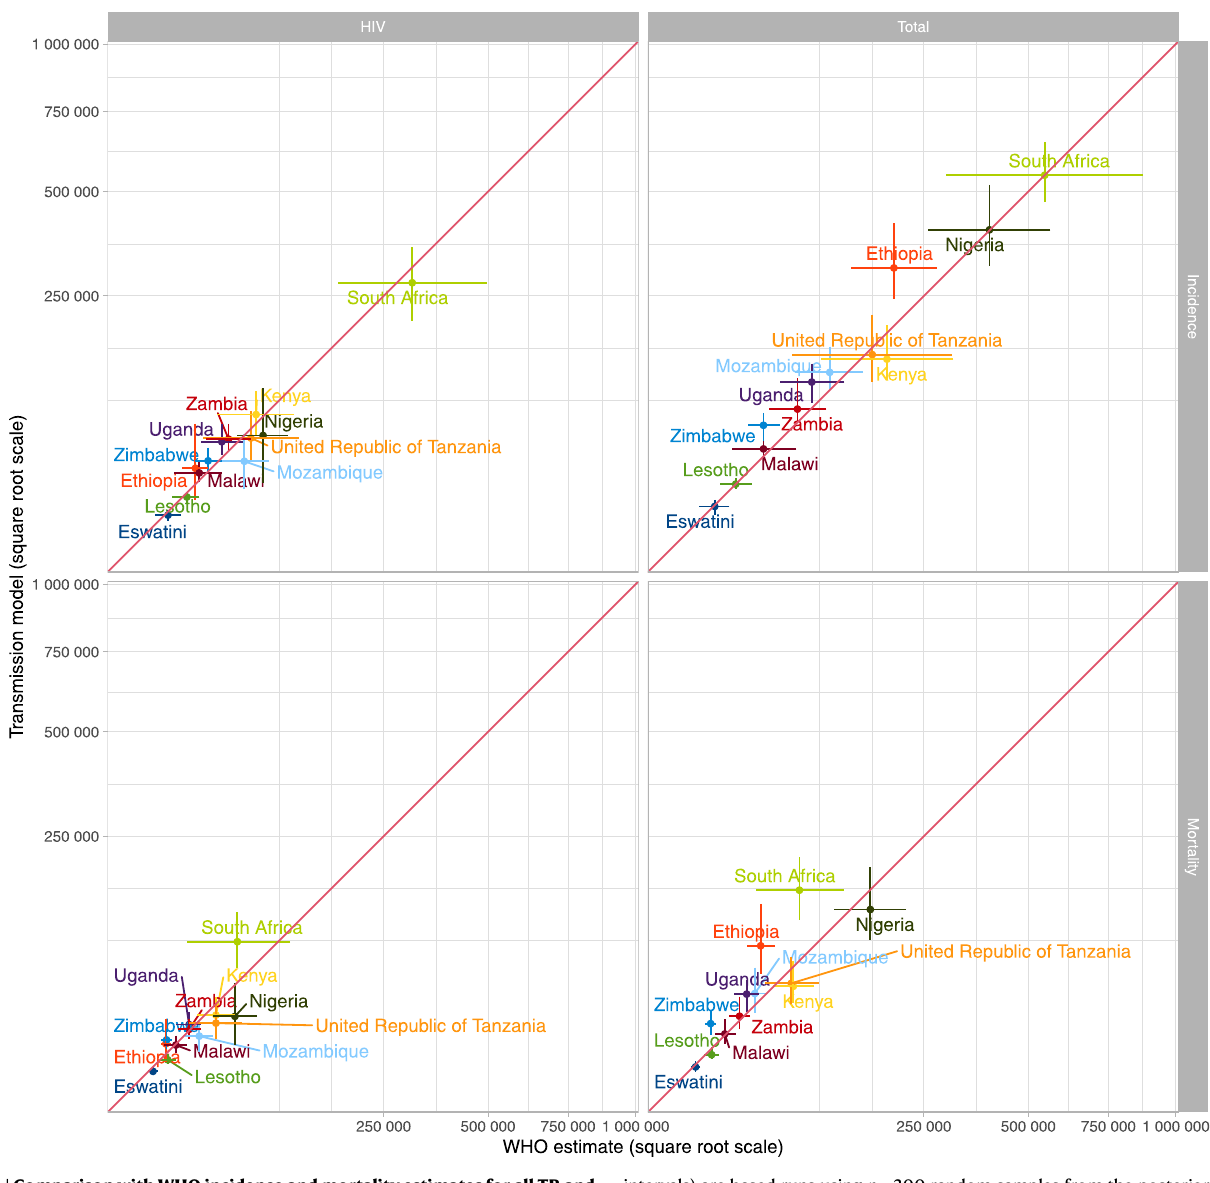
intervals) are based runs using n =300 random samples from the posterior para- meter distribution for each country. Central estimates and UIs for WHO data (x- axis) are as